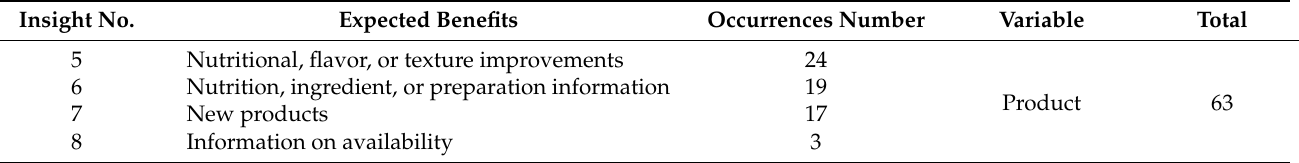
Table 5. Subgroup of products classified into the product